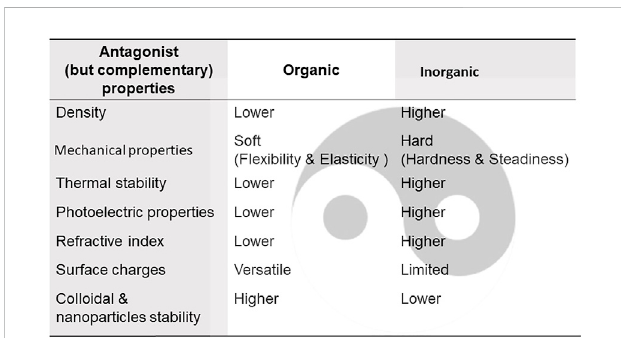
FIGURE 12 Antagonist (yin-and-yang), but complementary, properties of most common inorganic and organic compounds motivating their incorporation into hybrid